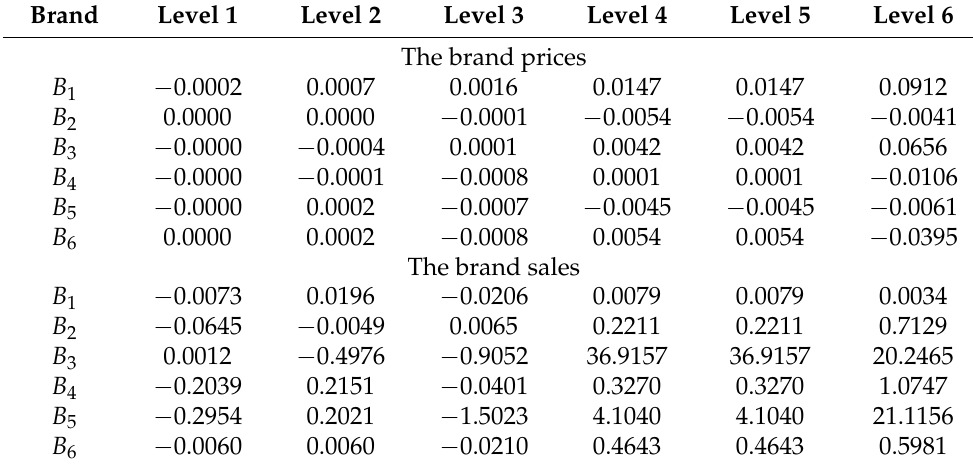
Table 3. Mean wavelet coefficients for brand prices and sales at different levels. Brand Level